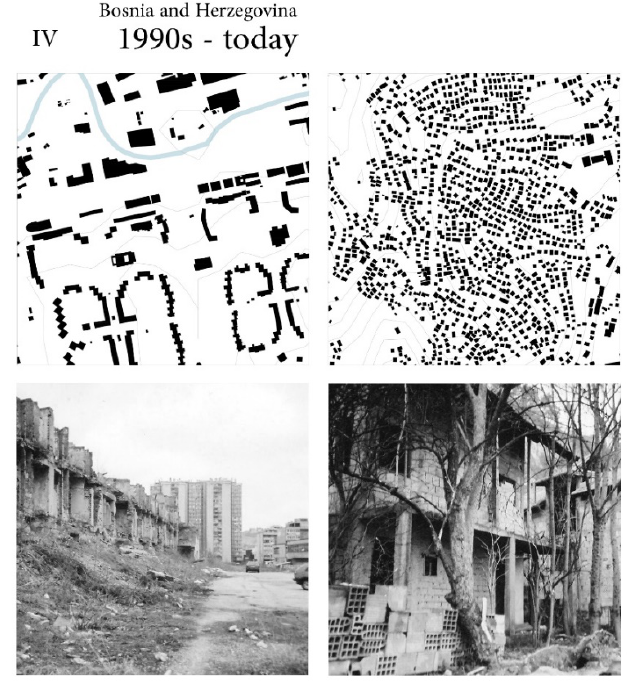
Figure 6: The new city in the valley in plan and image (left column) and the upper-hill settlements in plan and image (right